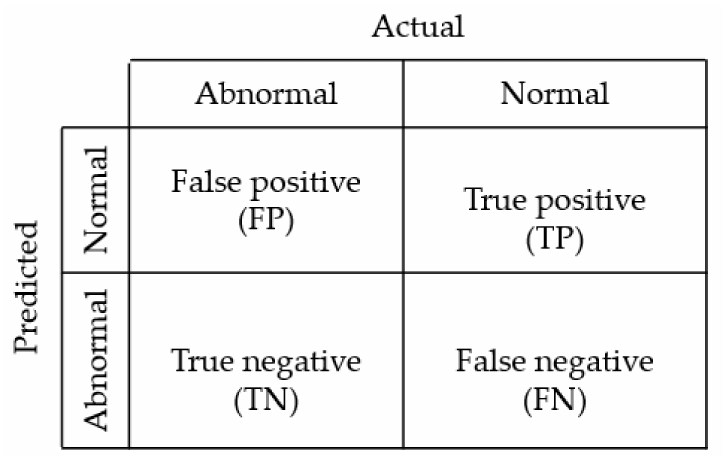
Figure 8. Structure of the confusion